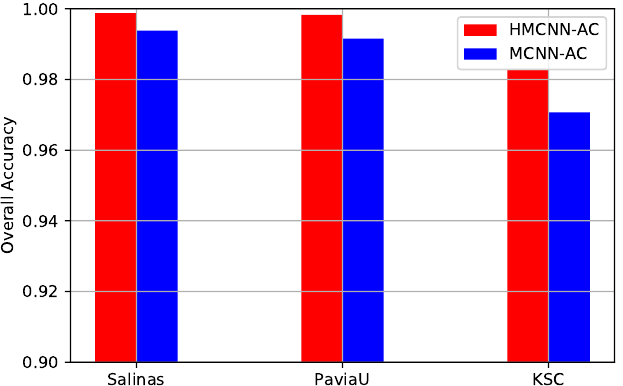
Figure 14. OAs comparison of the proposed MCNN-AC and HMCNN-AC on three datasets for effective analysis of bidirectional LSTM. For all three HSIs, OA value decreases for the constructed MCNN-AC framework, which validates the effectiveness of the adopted bidirectional